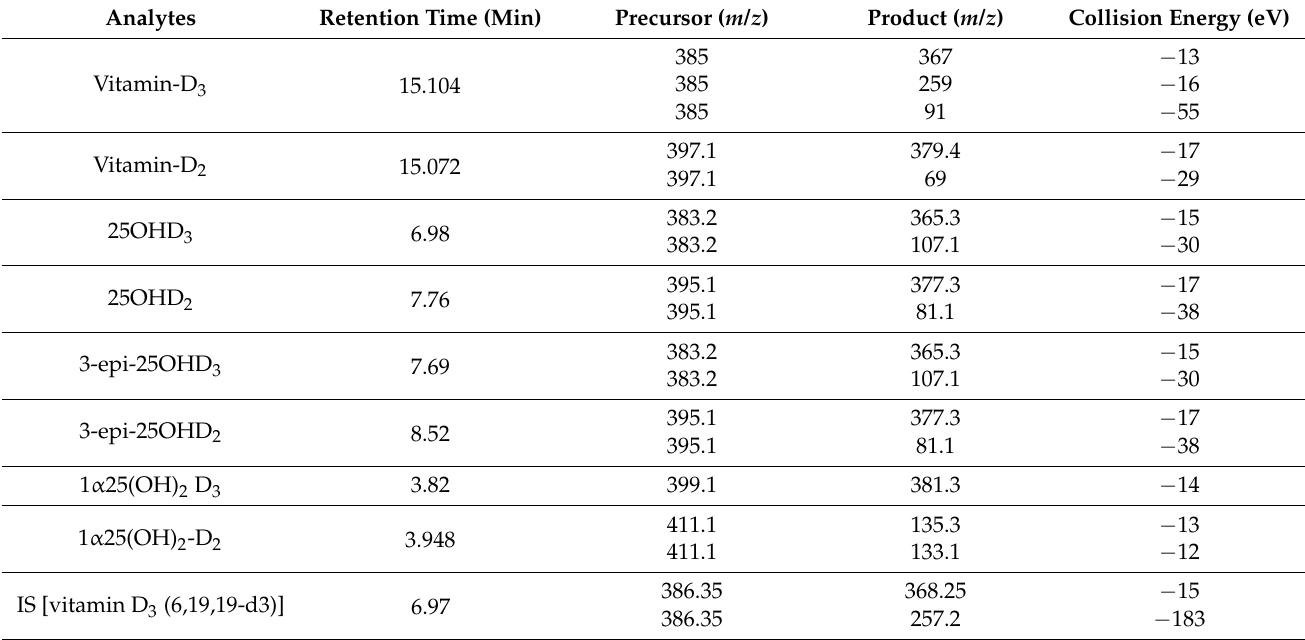
Table 1. Retention times, MRM transitions, and collision energy conditions of each